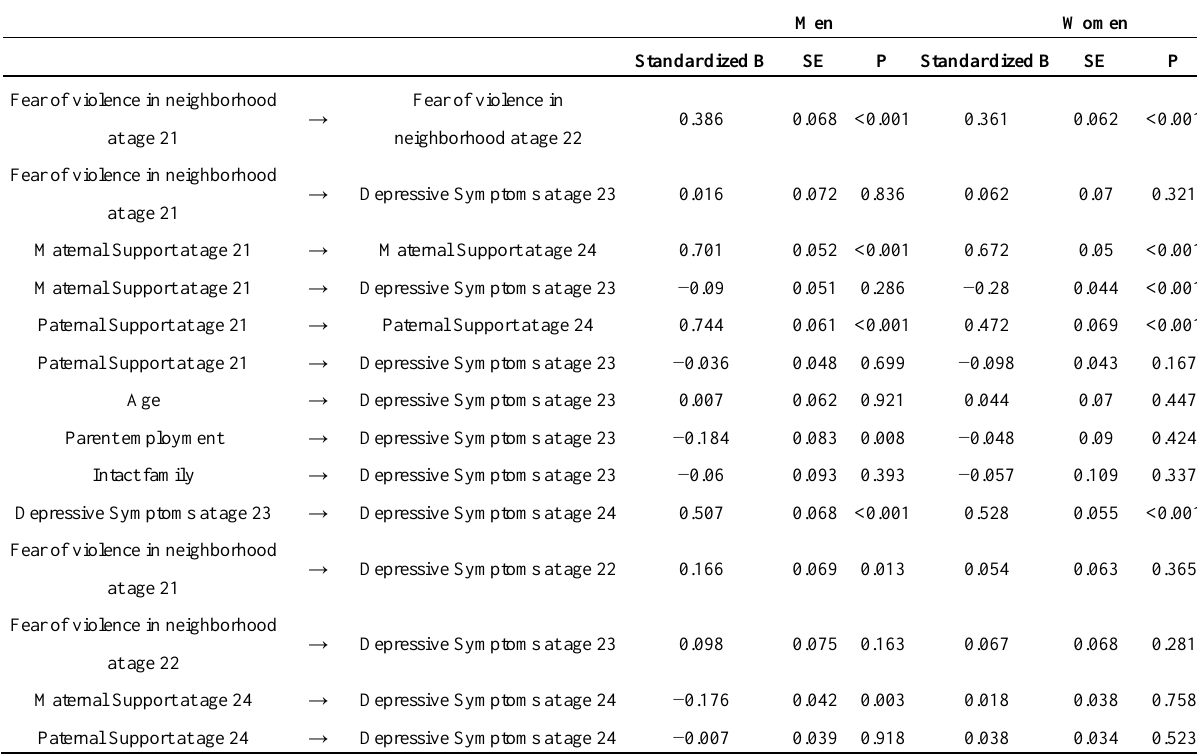
Table 3. Summary of path coefficients among male and female African American